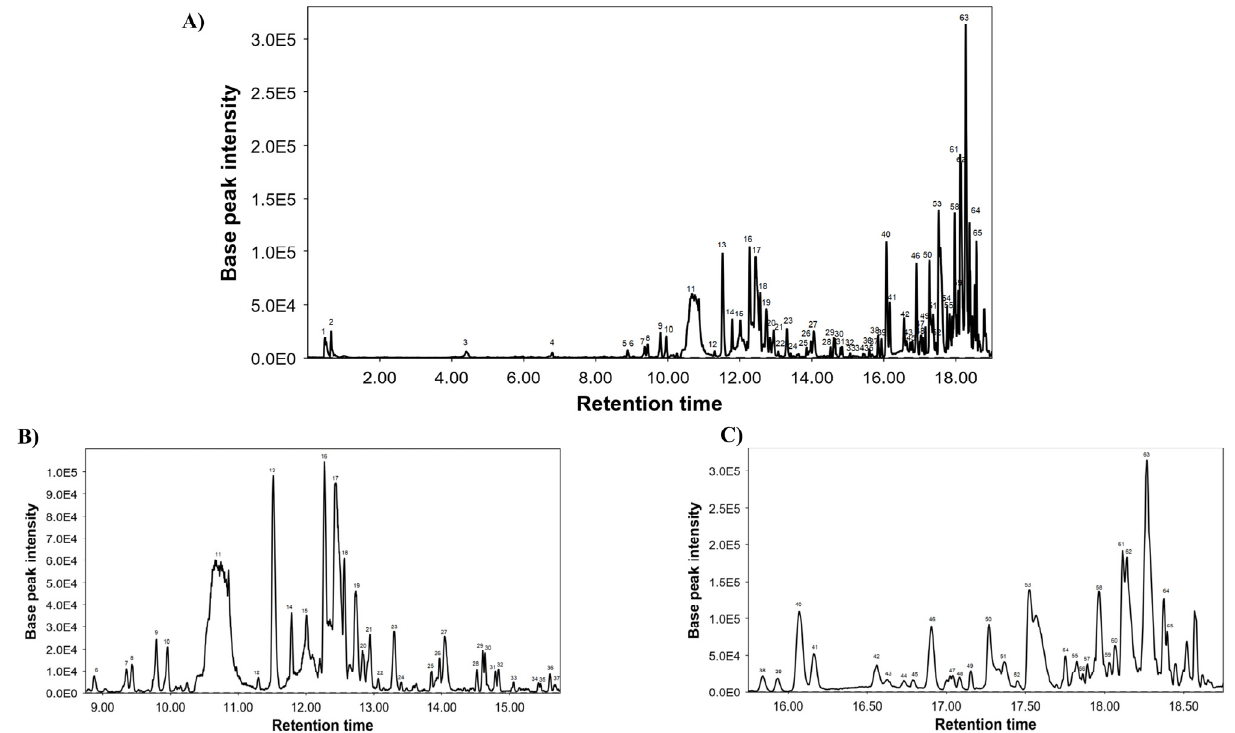
Figure 1. Base peak chromatogram of LME by UHPL-QTOF: ( A ) full chromatogram, ( B ) retention time from 8.50 to 16 min, and ( C ) retention time from 16 to 18.7 min. They are included in Table 1 and numbered in accordance with their elution order.